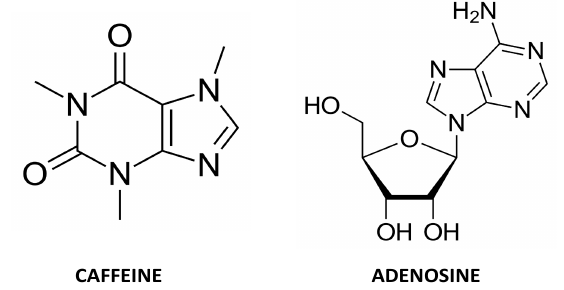
Figure 3. The comparison of caffeine and adenosine chemical structures.